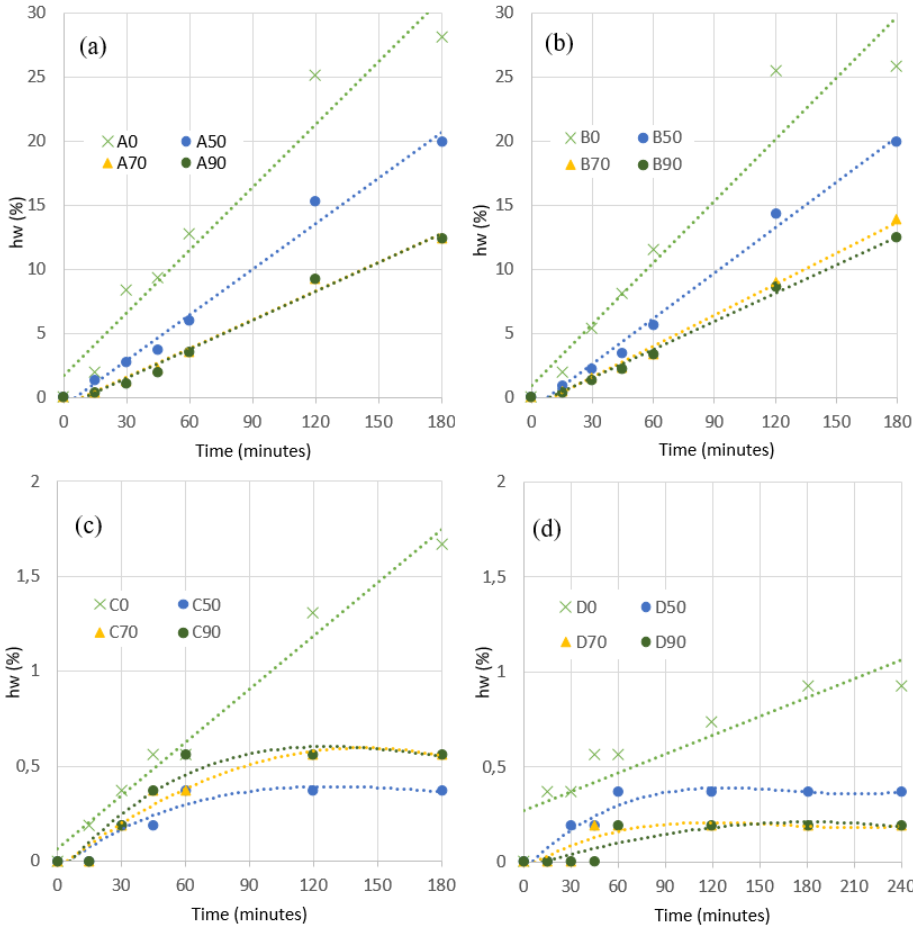
Figure 6. Average results of exudation tests. ( a ) Mixtures A. ( b ) Mixtures B. ( c ) Mixtures C ( d ) Mixtures D.